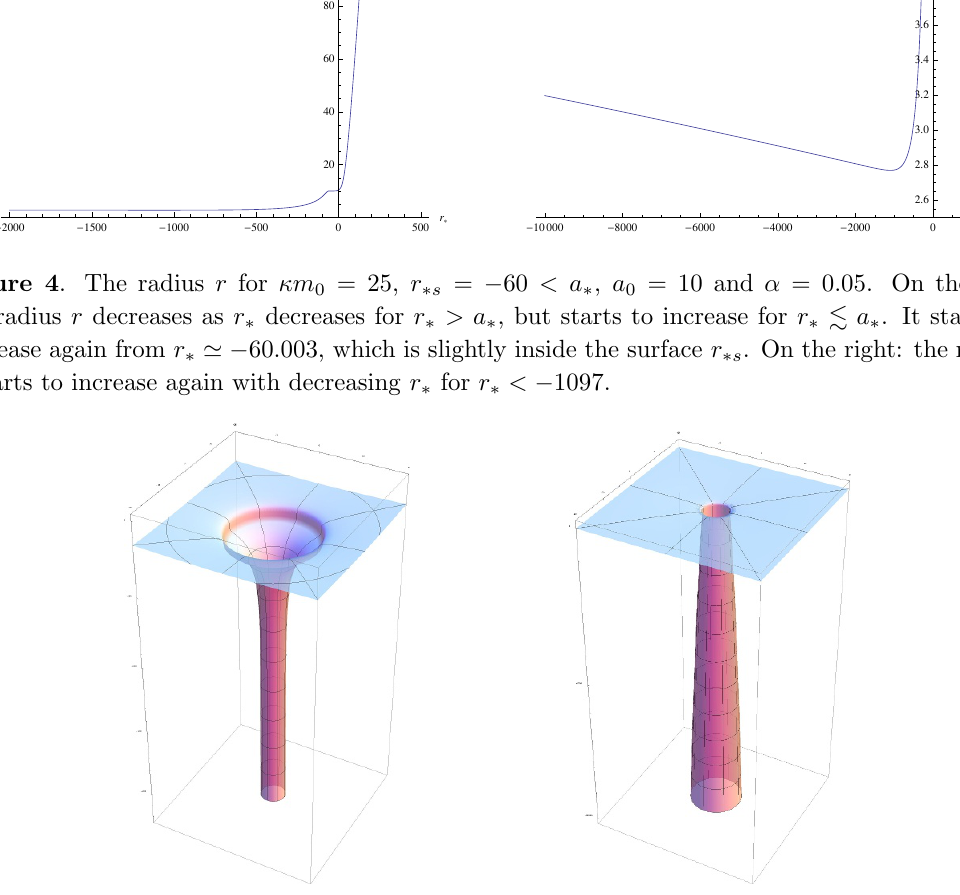
Figure 5 . Schematic 3D picture for the case of (cid:12)gure 4. The radius r corresponds to that in the horizontal direction while the distance along the 2D surface in the picture is given by the change in the r (cid:3) coordinate. Both pictures show the radius r on the same scale, but the range of r (cid:3) shown in the picture on the right is much larger than that on the left. The radius r ! 1 in both limits r (cid:3) ! (cid:6)1 . Notice that the distance along the 2D surface is di(cid:11)erent from the proper distance, which cannot be embedded in 3D (cid:13)at